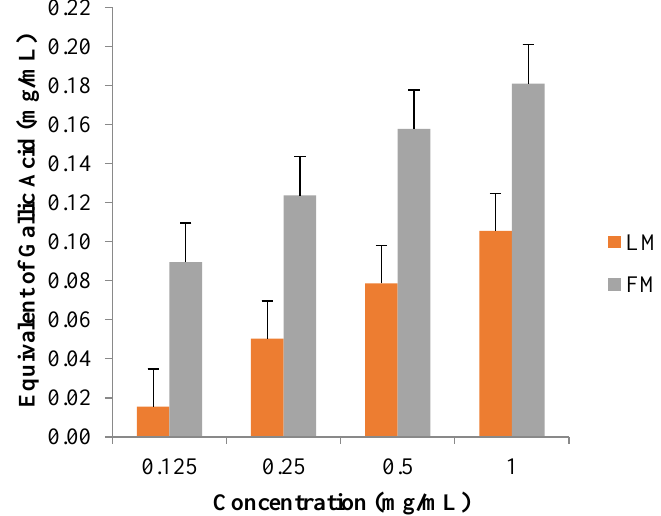
Figure 5. Equivalent of gallic acid (mg) per 1 mL extract of LM and FM extracts.